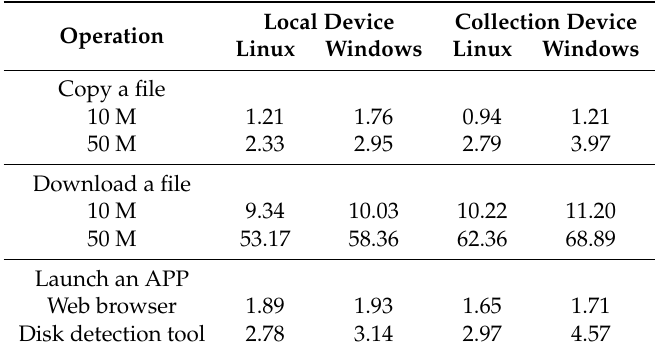
Table 4. Operation latency in Linux and Windows